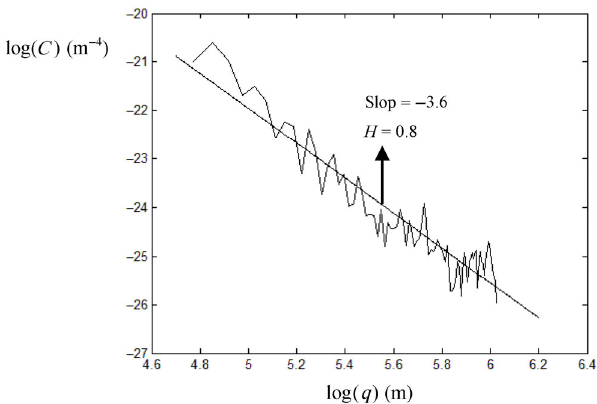
Fig. 5 Auto spectral density function as a function of the wave vector q for the finger skin. The straight line has the slope 2(1 ) 3 6 H      corresponding to the Hurst exponent 0 8 H   and fractal dimension 3 2 2 D H     . f